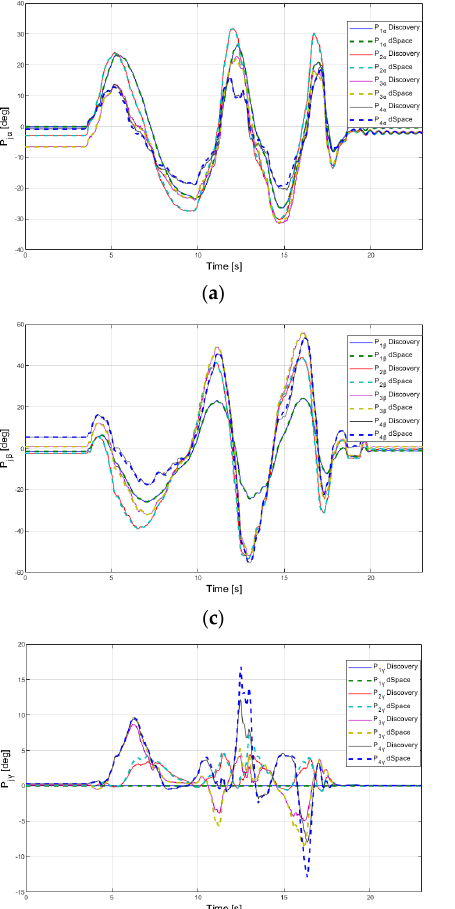
P j α { j = 1...4} in Figure 11a, parameter P j β { j = 1...4} in Figure 11 c and parameter P j γ { j = 1...4}